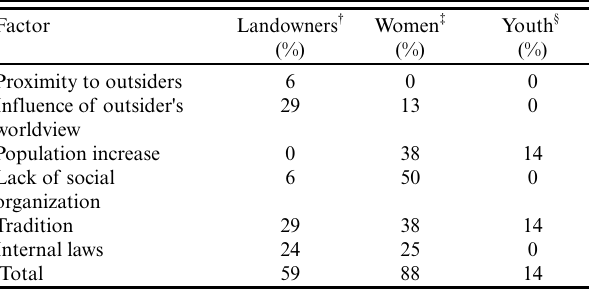
Table 2 . Social–cultural factors that influence land-use decisions, as mentioned by interviewees.